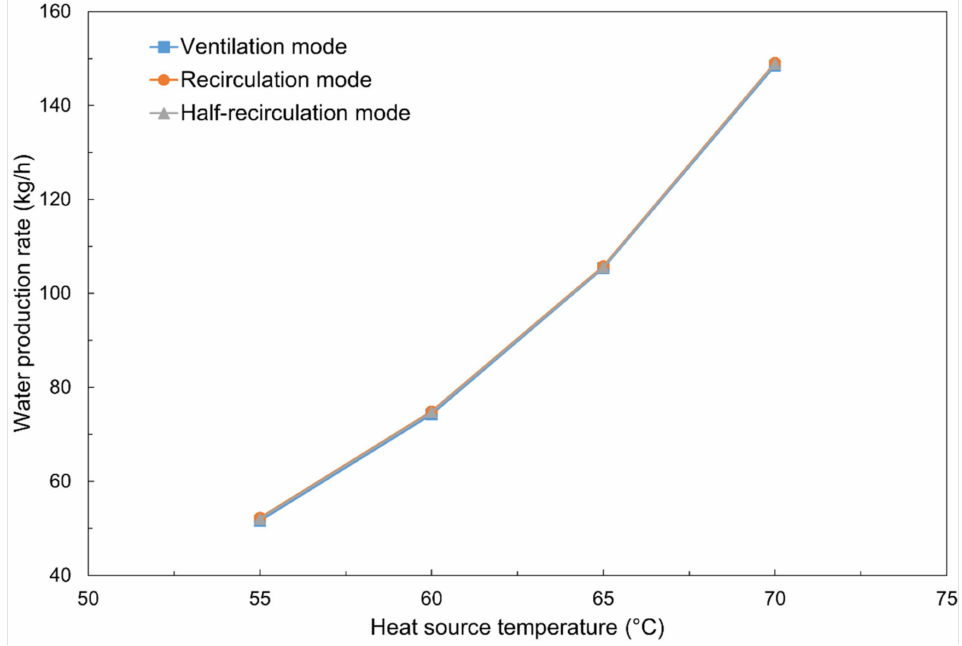
Figure 10. Effect of heat source temperature on water production